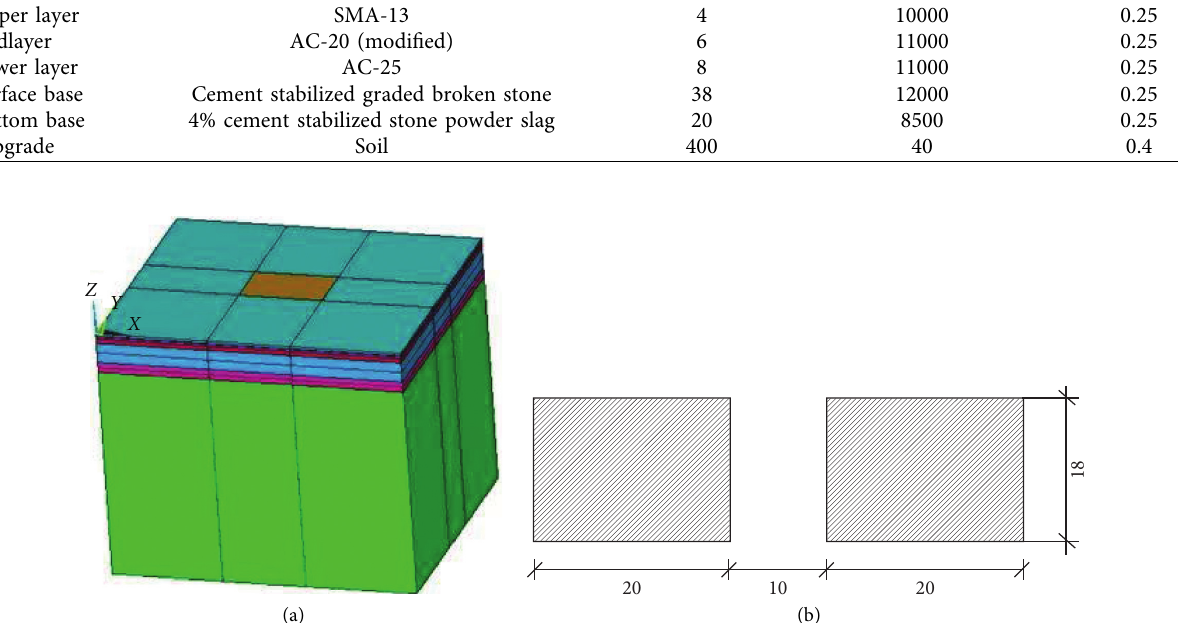
Figure 2: (a) Finite element model. (b) Double-wheel uniform load (unit: cm).